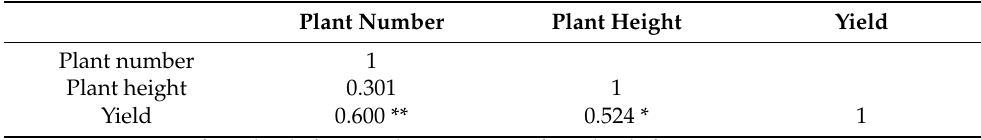
Table 3. Correlation analysis of the UAV-based structural features and yield. Plant